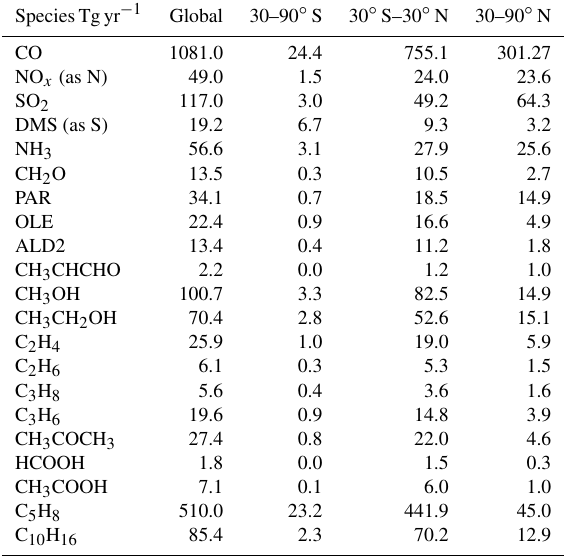
Table 3. The zonally segregated emission totals introduced into TM5-MP for the year 2006. All organic hydrocarbons are given in TgCyr − 1 , except for CO (TgCOyr − 1 ) , CH 2 O (TgCH 2 Oyr − 1 ) and CH 3 OH (TgCH 3 OHyr − 1 ) . All NO x emissions are intro- duced as NO (TgNyr − 1 ) . For SO 2 emission totals are given as cur for HNO 3 , PAN, ORGNTR, HONO, N 2 O 5 , NO 2 , CH 3 O 2 NO 2 or O 3